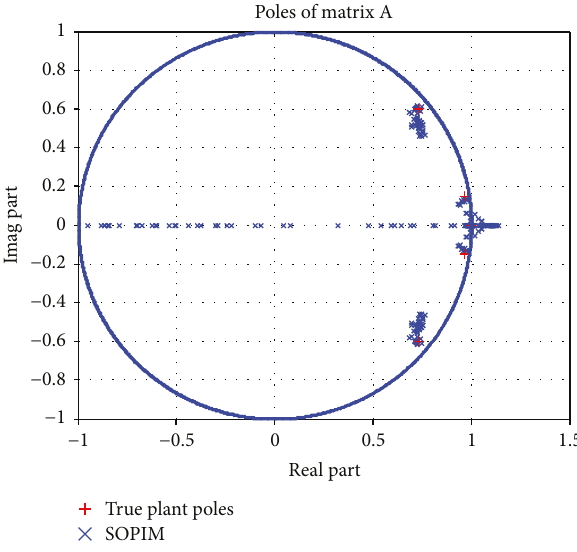
Figure 7: SOPIM simulation and comparison of root loci.